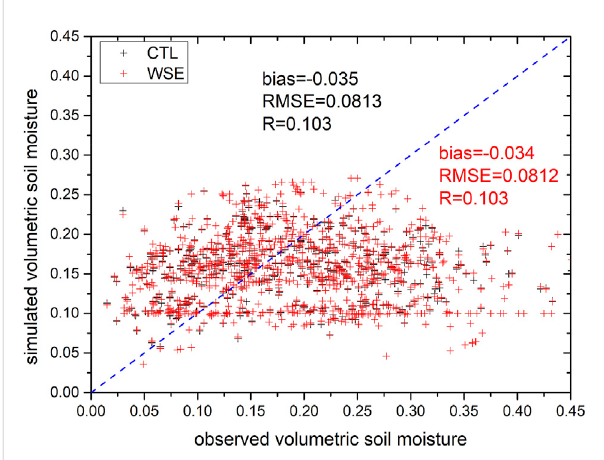
Scattered plot of the monthly average 10-cm-deep volumetric soil moisture from autonomic soil moisture observation sites and IUM